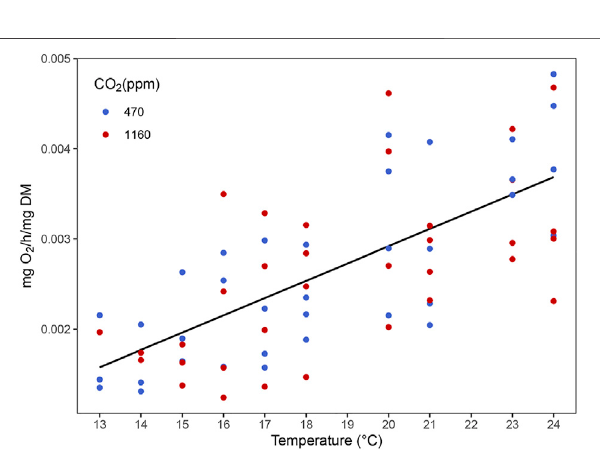
FIGURE 6 | Effect of temperature on the routine metabolic rate of stage III Homarus gammarus larvae. Each point represents the average response quanti fi ed in larvae originated from the same female. Curves correspond to smooths fi tted with the best (general additive) model, obtained after backwards model selection.